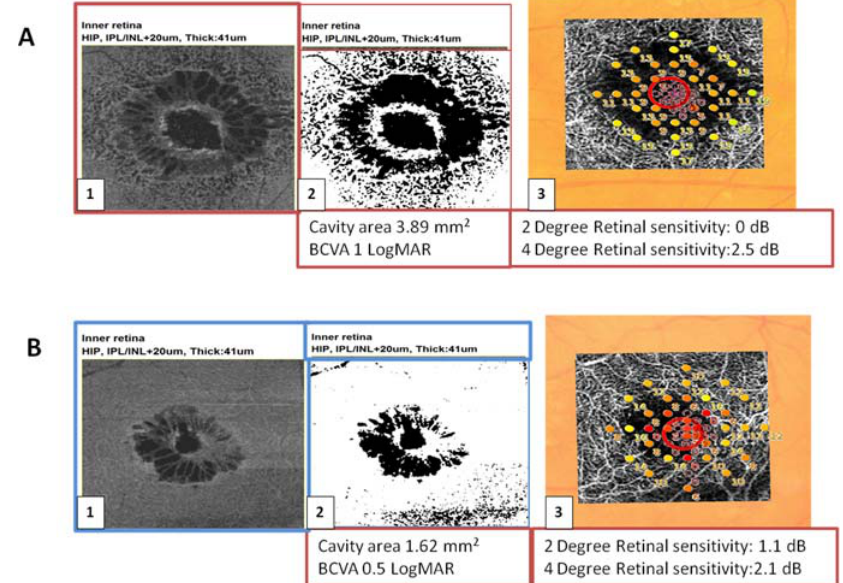
Figure 4. ( A ) 1. En face scan of the OPL + HFL complex of a large MH. 2. The extension of cystic cavities measured on the slab corresponding to OPL + HFL complex assessed by OCT en face, using the Image J software. In the lower part the corresponding cavity area in mm 2 and the Best Corrected visual Acuity in LogMAR are indicated. 3. Overlay of the microperimetry (2 ◦ retinal sensitivity) on the slabs corresponding to the deep capillary plexus on OCTA. ( B ) 1. En face OCT (OPL + HFL complex) of a smaller macular hole. 2. The extension of cystic cavities measured on the slab corresponding to OPL + HFL complex assessed by OCT en face, using Image J software. 3. Overlay of the microperimetry (2 ◦ retinal sensitivity) on the slabs corresponding to the deep capillary plexus on OCTA.